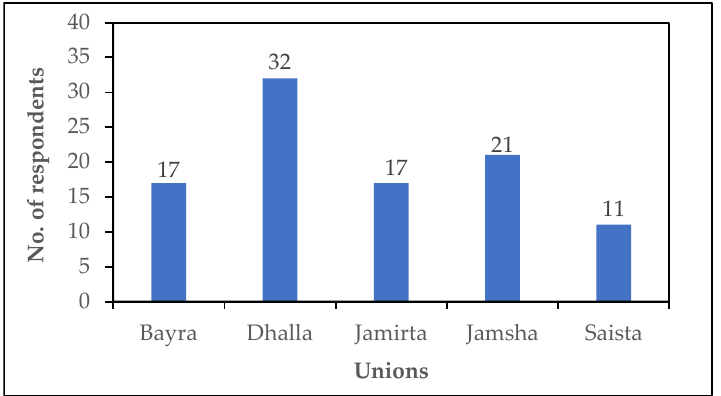
Figure 5. Number of respondents reporting water sources contaminated with both arsenic and iron.